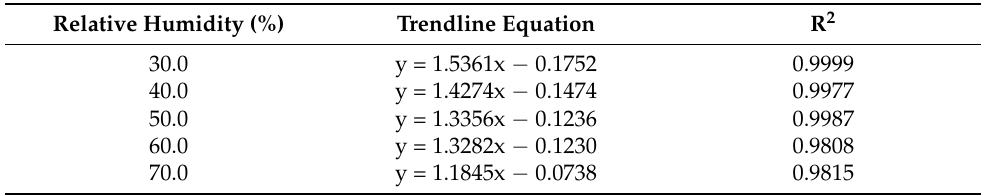
Table 3. Trendline equations and correlation coefficients for auxiliary and working electrode relationships across varying humidity’s.